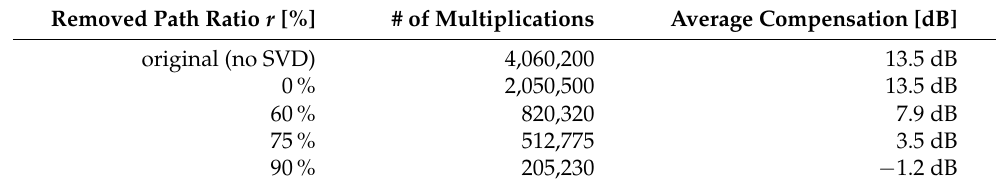
Table 3. Comparison of number of multiplications for the ratio of removed singular values. Removed Path Ratio r